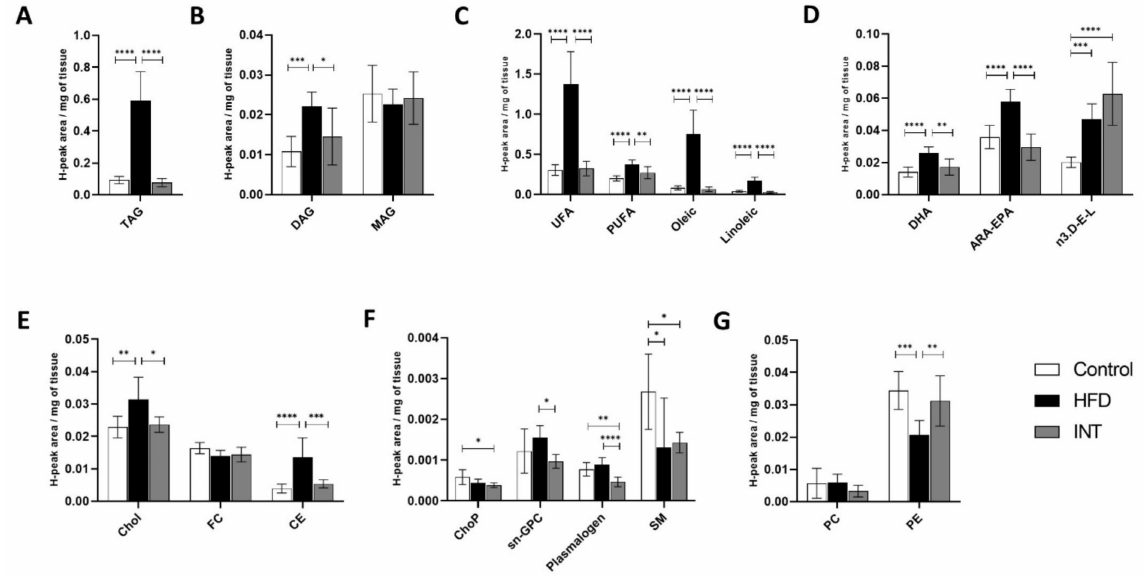
Figure 5. Alterations in metabolite lipid profile in liver. Representation of the changes induced by HFD and the intervention following the HFD on the presence of ( A , B ) glycerolipids, ( C , D ) fatty acids, ( E ) sterol lipids and ( F , G ) phospholipids and sphingolipids. Ctrl n = 8, HFD n = 8, INT n = 7. Y-axis values indicate H-peak area/mg of tissue. Data represented as mean ± SEM, one-way ANOVA and post-hoc Tukey’s tests, * p < 0.05, ** p < 0.01, *** p < 0.001, and **** p < 0.0001.